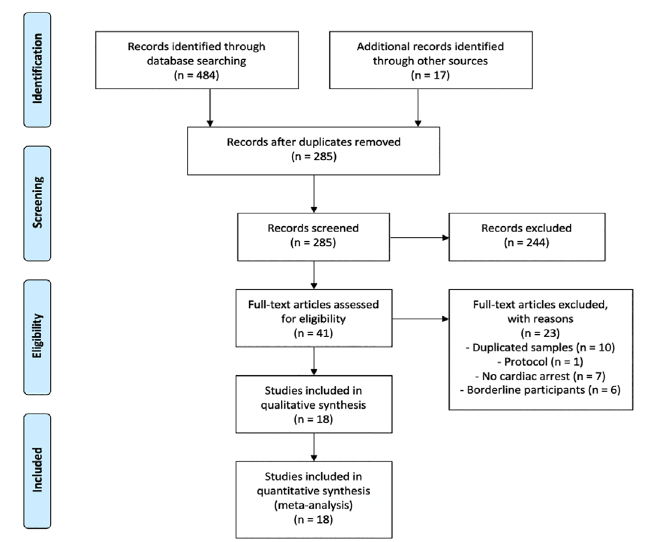
Figure 1. The PRISMA flow